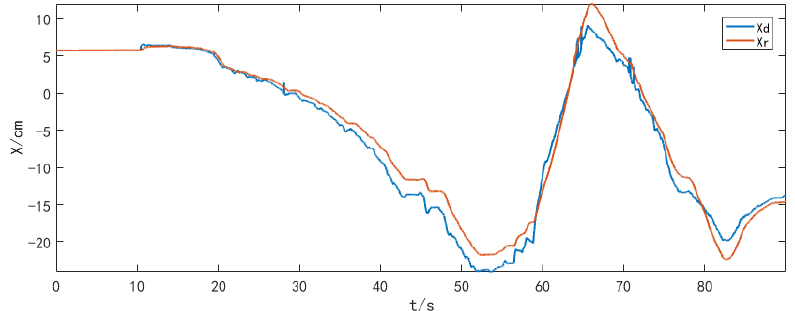
Figure 9. The result of X-axis.